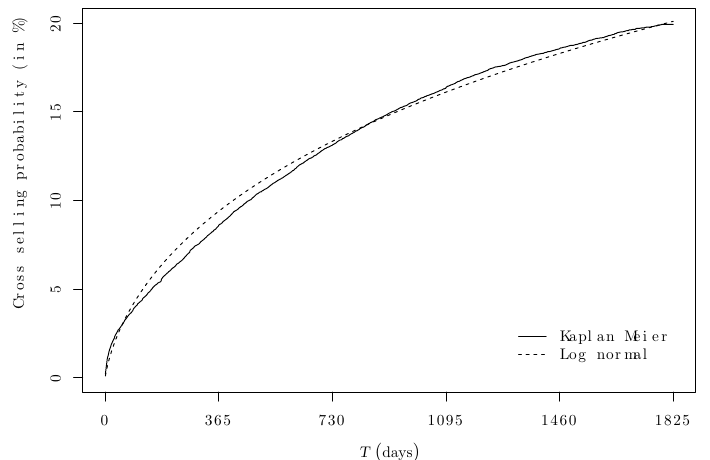
Figure 7. Kaplan–Meier estimates for the cross-selling probability and log-normal distribution fit for the CA